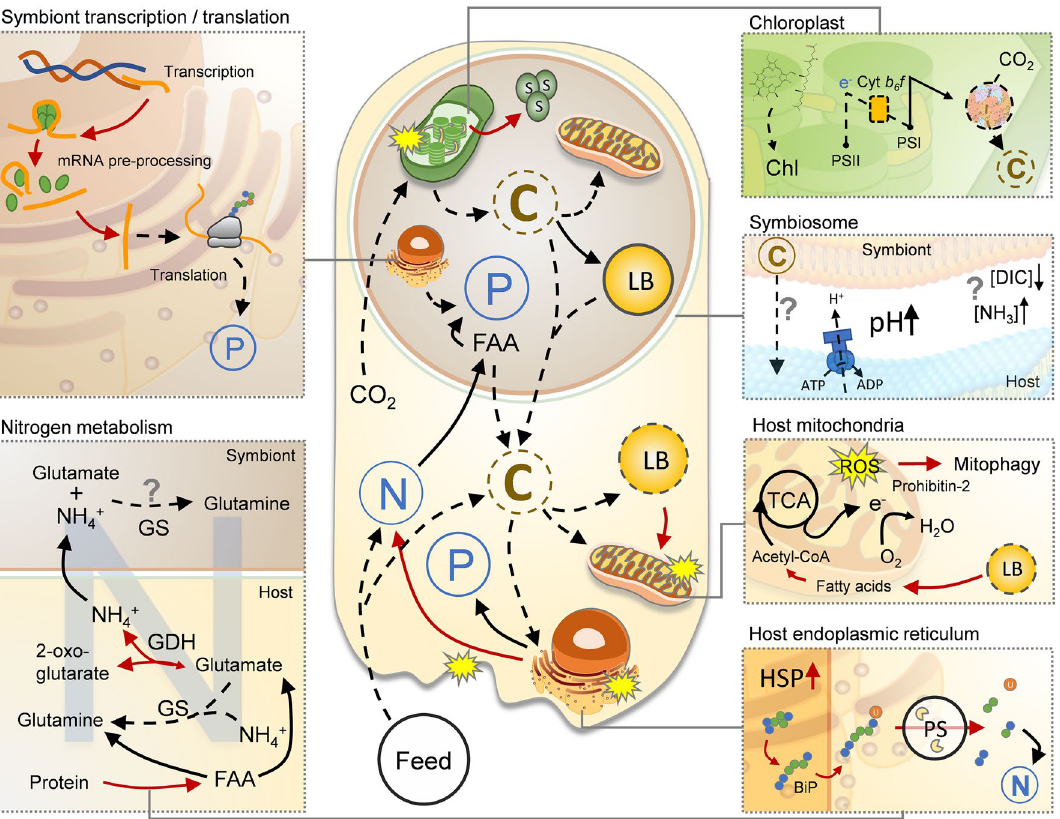
Figure 6. Simplified graphical summary of proposed major physiological changes based on differentially expressed proteins in the host and symbiont of Acropora millepora during thermal stress. Broken arrows indicate a decrease and red arrows indicate an increase in protein abundance or pool. Question marks indicate pathways with inconsistent evidence or potential follow-on effects of a